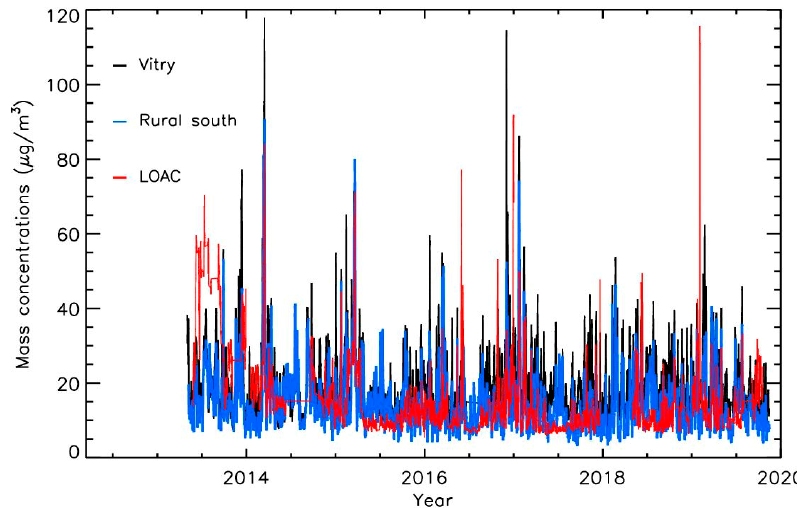
Figure 5. Temporal evolution of the PM10 mass concentrations from LOAC at the “Ballon de Paris Generali” and from the Airparif air quality network for stations in the suburb of Paris (Vitry) and in the rural area in the south of Paris region (the data have been smoothed by a sliding smoothing procedure with a width of 2 days).